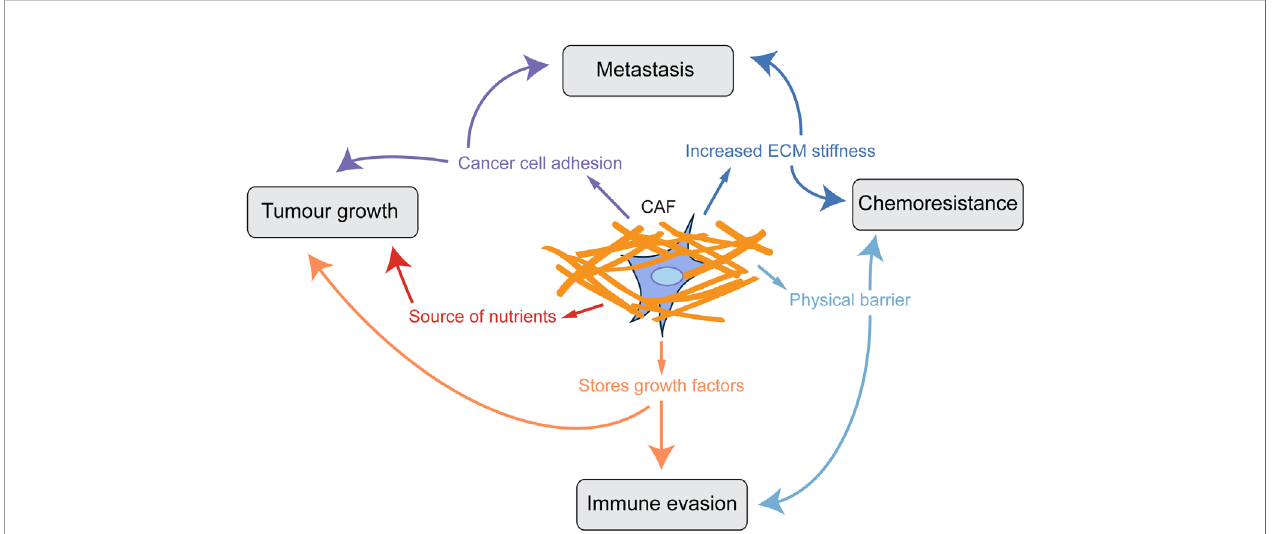
FIGURE 1 | CAF-derived ECM promotes tumour progression. Scheme showing how a collagen-rich ECM produced by CAFs in fl uences key aspects of tumour